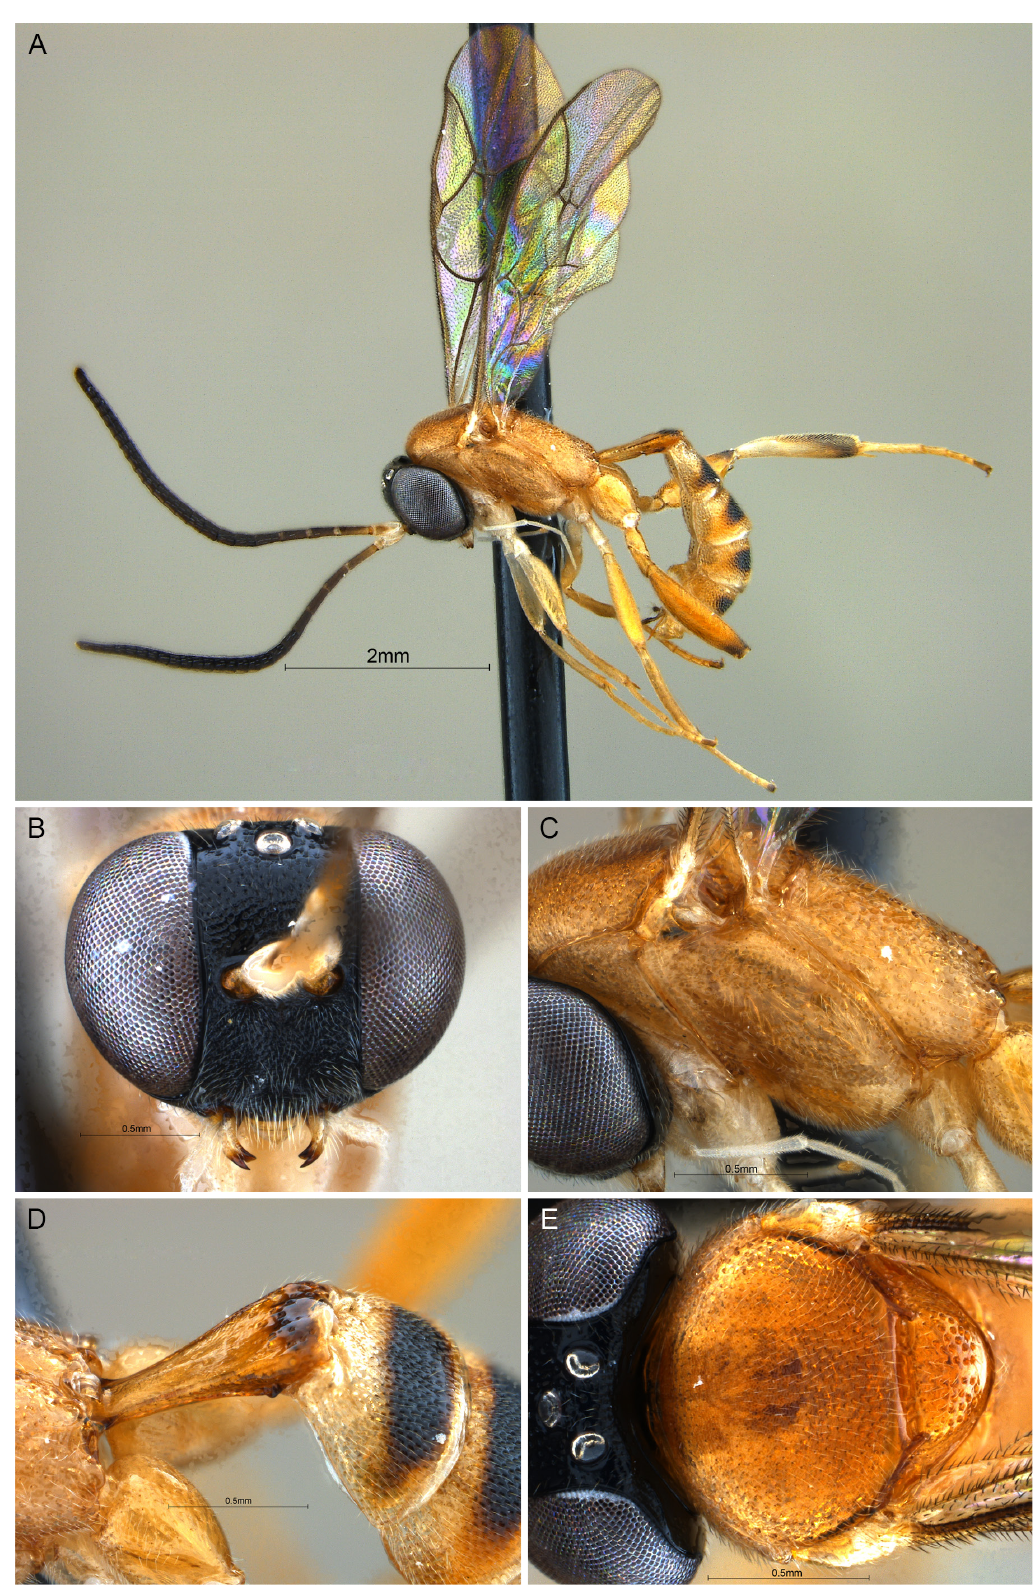
Fig. 7. Palpostilpnus angka sp. nov., holotype, ♀ (QSBG 2014-242) . A . Lateral habitus. B . Head, anterior view. C . Mesopleuron. D . T1, dorsolateral view. E .